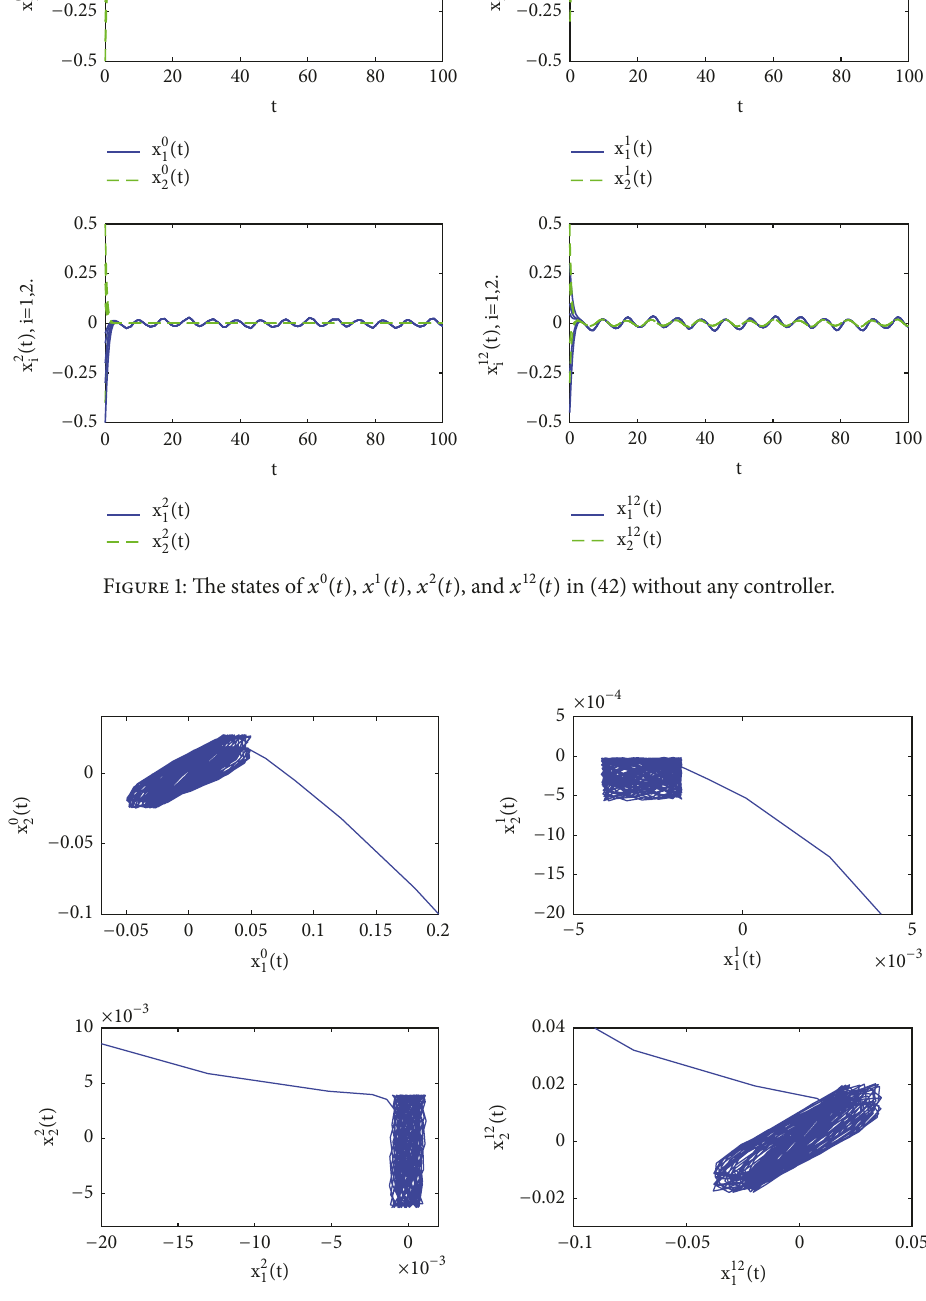
Figure 2: The states of four parts of 𝑥 1 (𝑡) and 𝑥 2 (𝑡) in 2-dimensional space without